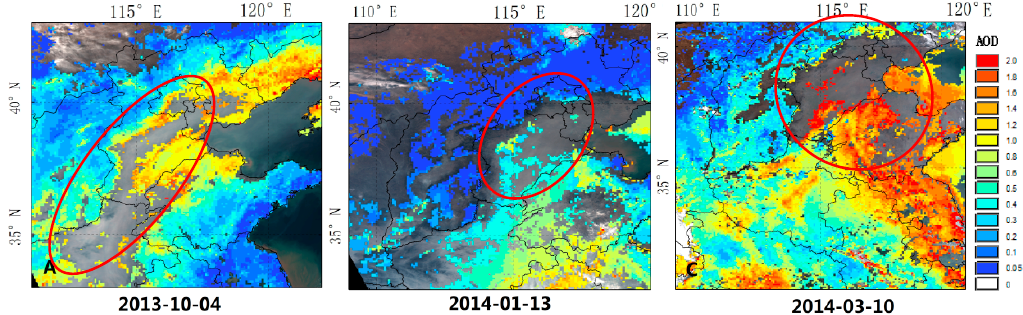
Figure 2. National Oceanic and Atmospheric Administration (NOAA)’s VIIRS AOD products (all data quality) over hazy areas. The AOD products were overlaid on the true color image, and no retrieval areas were set as transparent. Some AOD values are invalid, which are marked with red ellipses, because of heavy haze events.